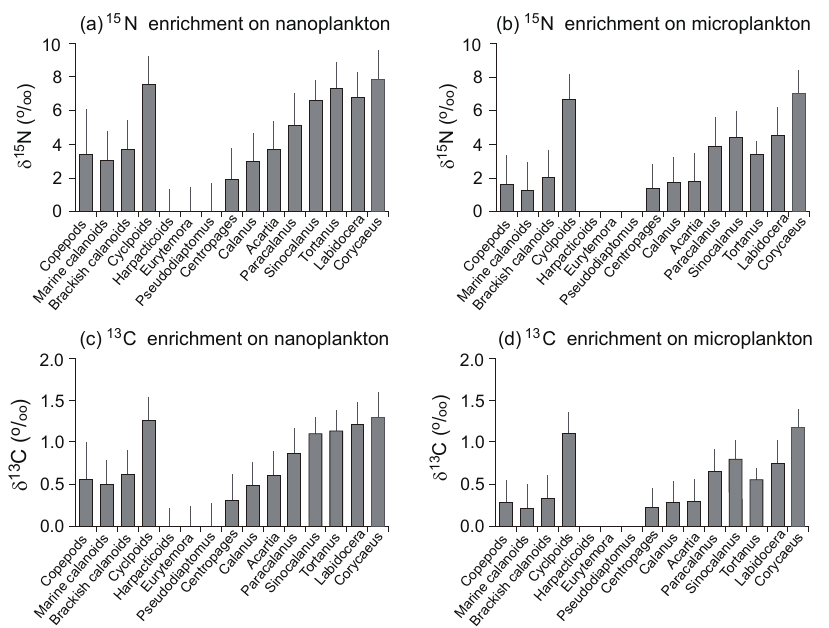
Figure 5. Trophic enrichment (or fractionation factor) from basal food items (nanoplankton: a, c ; microplankton: b, d ), based on the dif- ference of each sample’s δ 15 N between higher trophic level and lower trophic level; a 0.5‰ per one trophic level was used to calculate the δ 13 C enrichment for each group. Reference lines indicate mean values from all groups.